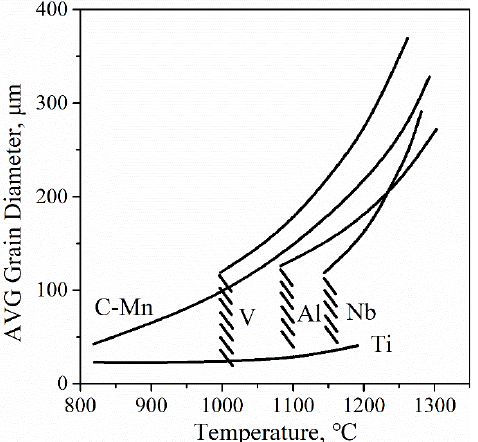
Figure 8. Effect of Nb, V, and Ti microalloy elements on austenite grain growth [64,65]. This figure is reproduced based on [64,65].